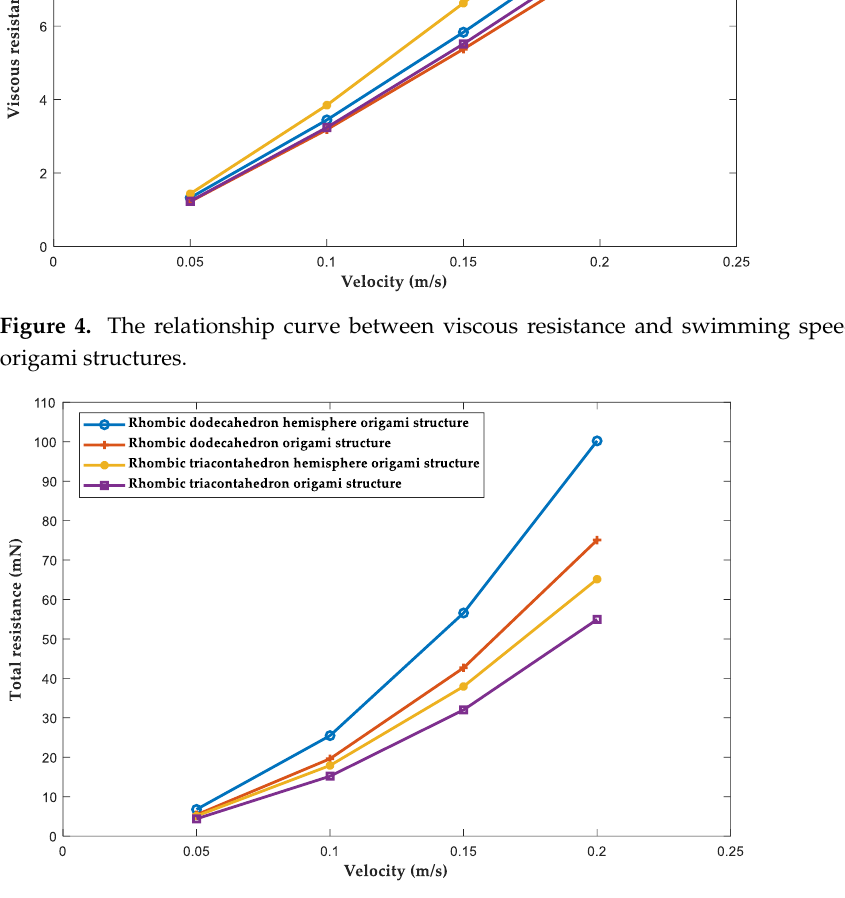
Figure 5. The relationship curve between total resistance and swimming speed of different origami structures.